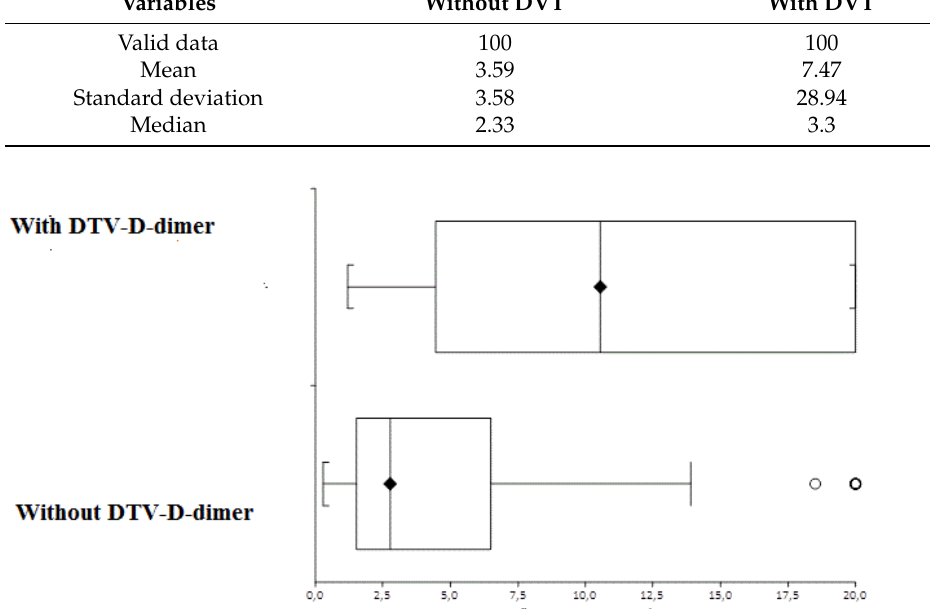
Figure 1. Median D-dimer levels and interquartile ranges in patients with and without deep-vein